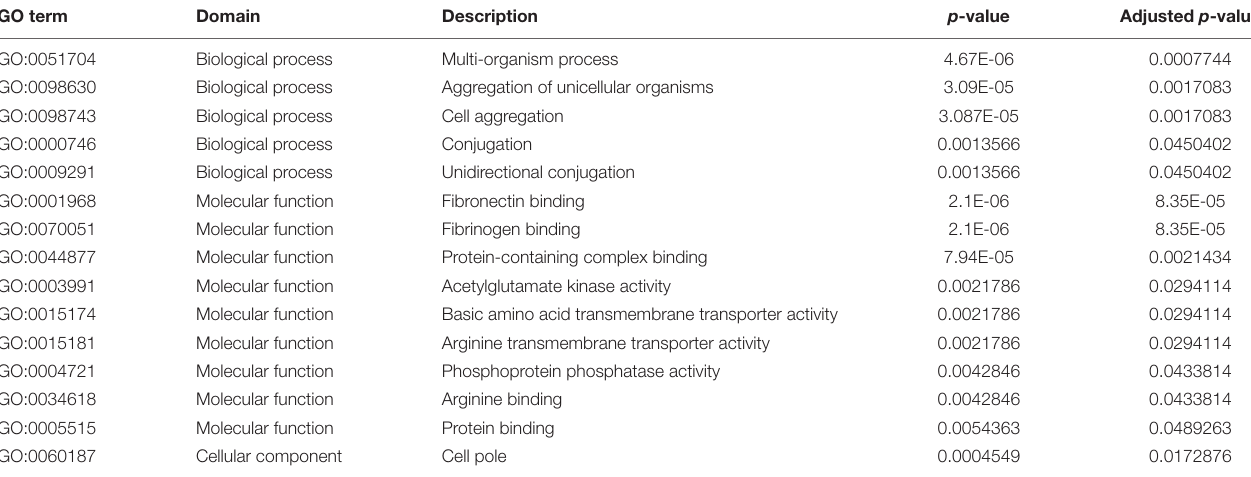
TABLE 2 | Enriched gene ontology (GO) terms for the genes found only in the peracute samples (in at least one).